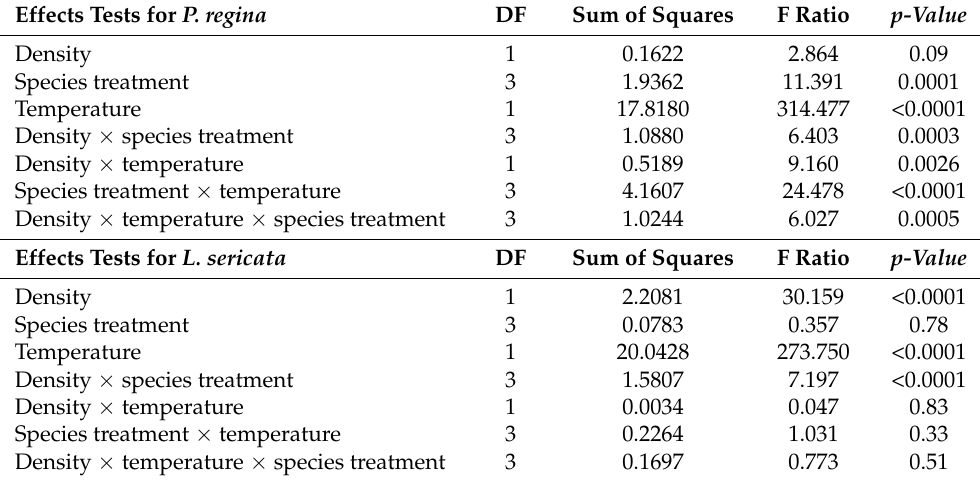
Table 2. Analysis of variance testing the effects of temperature, density, and species treatment survival to adult of Phormia regina Meigen and Lucilia sericata Meigen (Diptera: Calliphoridae). α = 0.05 for all